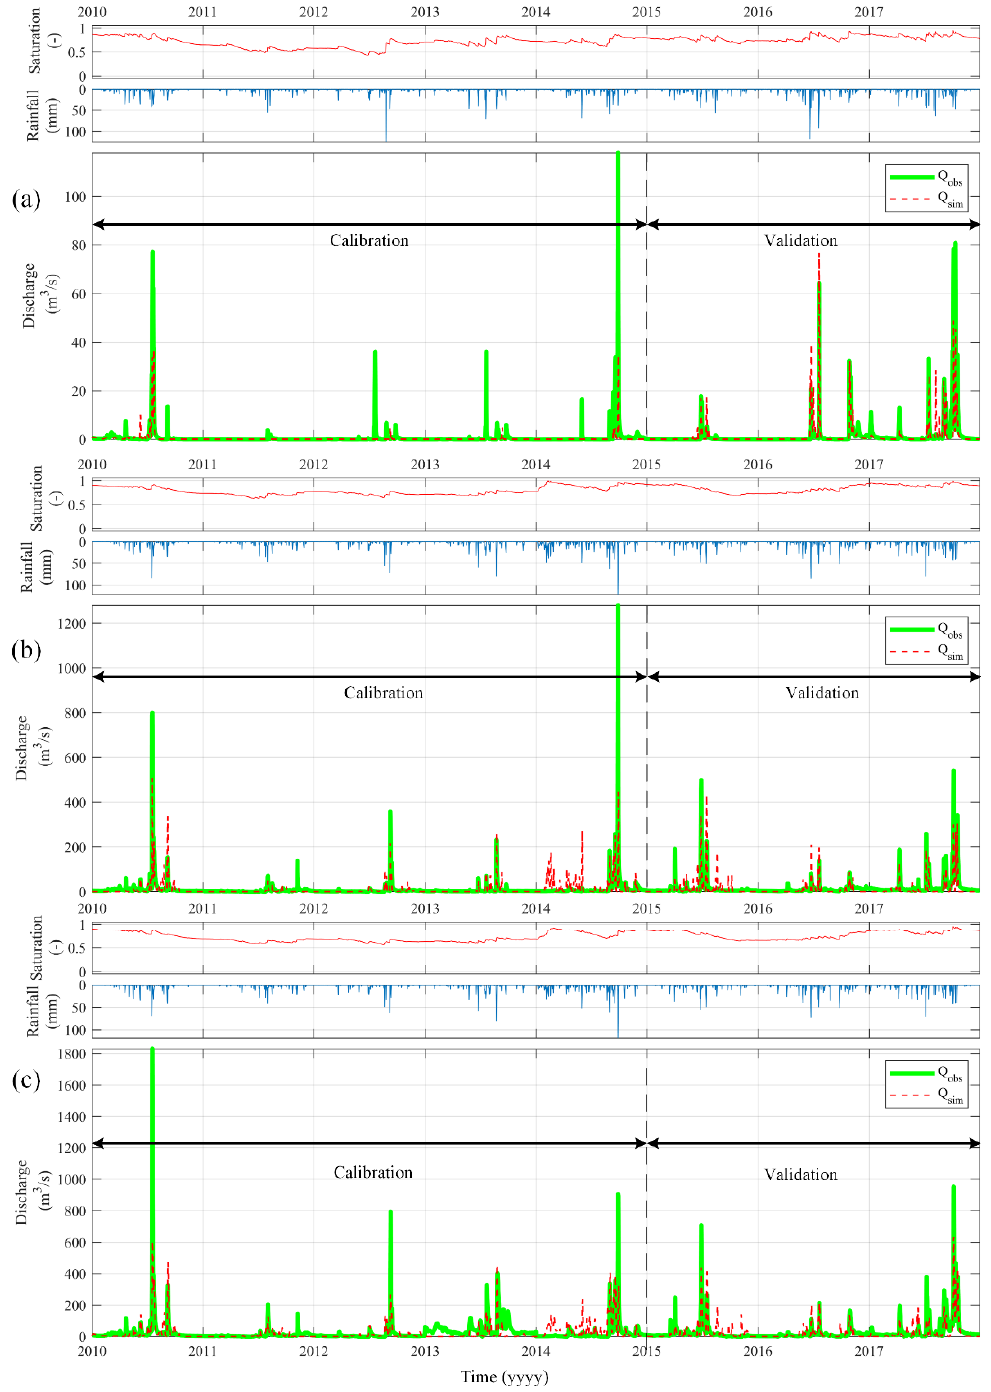
Figure 6. Comparisons of the observed, Q obs , and simulated, Q sim , discharge (lower panel) for the calibration and validation periods at the ( a ) WWQ, ( b ) DPL and ( c ) CTG basins. The upper panels also show the temporal pattern of soil saturation and